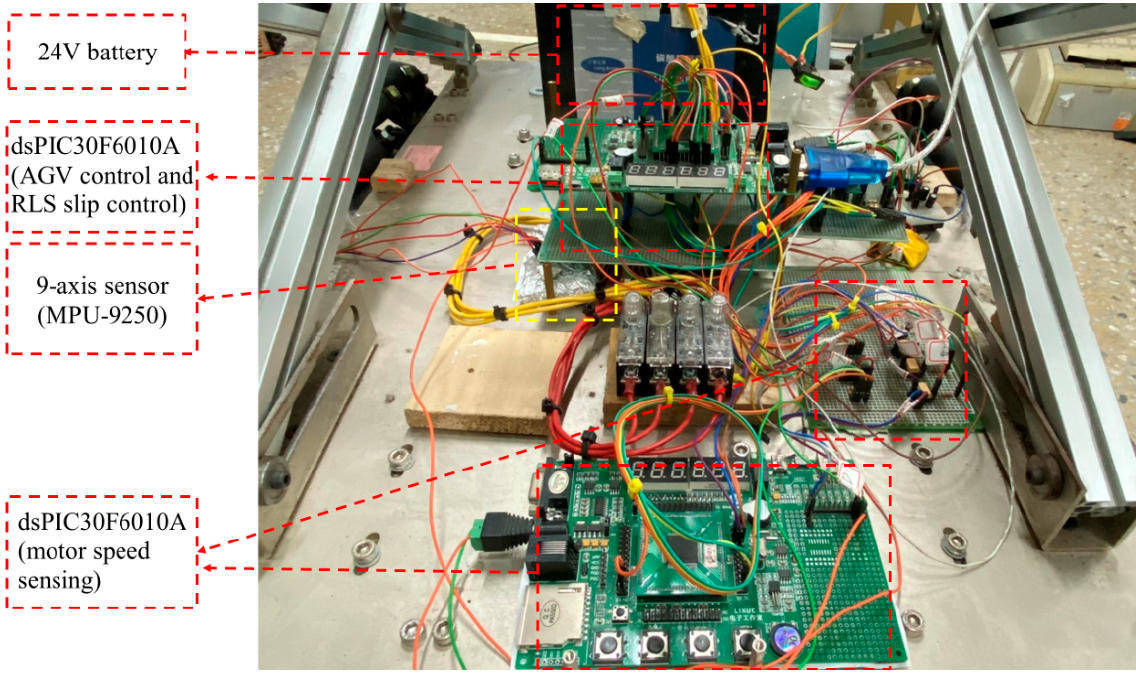
Figure 5. The hardware of the experimental system.